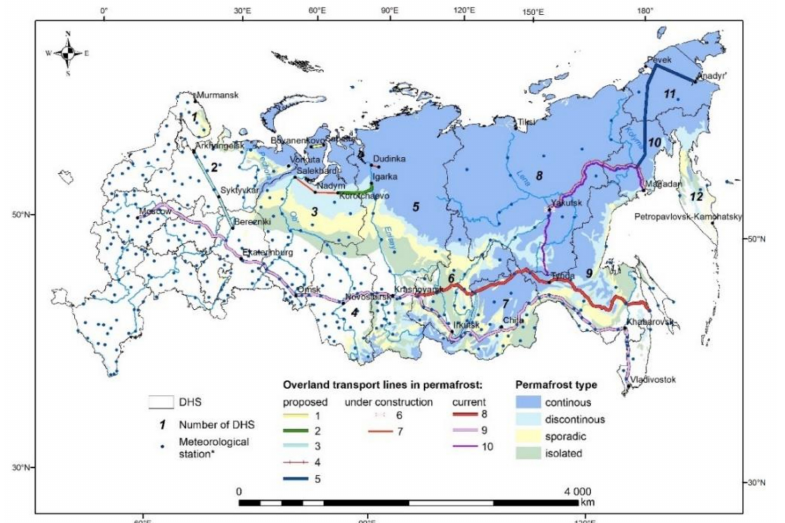
Figure 1. Distribution of permafrost type in the departments of Russian Hydrometeorological Service (DHS) located in permafrost zone (the number of DHS corresponds with Tables 1 and 2) and * the meteorological stations of Russian Hydrometeorological Service monitoring ground temperature